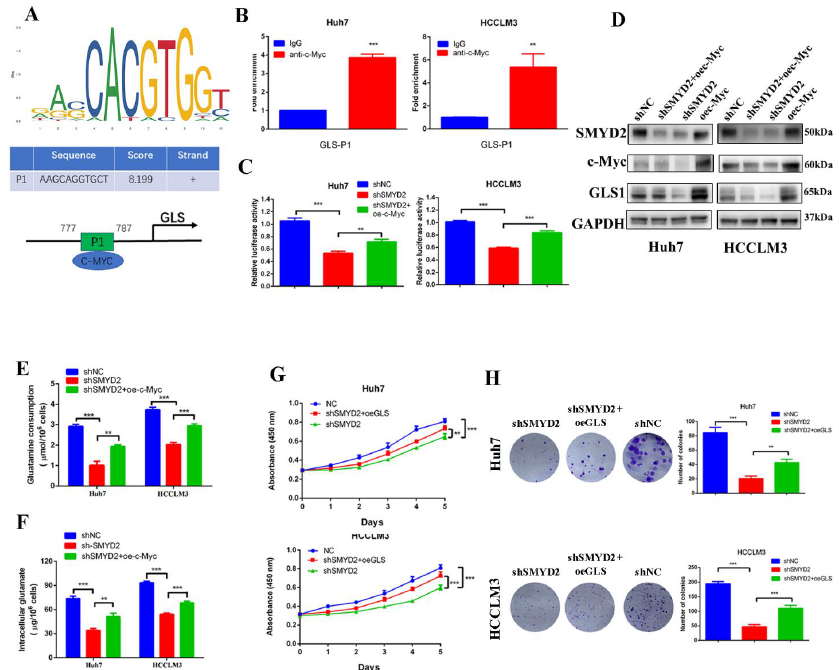
Figure 6. SMYD2 upregulates the expression of GLS1 through c-Myc. ( A ) Schematic illustration shows the potential c-Myc-binding site. ( B ) The enrichment of c-Myc on the GLS1 promoter was examined using ChIP- qPCR assay. The presented data were analyzed by Student’s t -test. ** p < 0.01, *** p < 0.001. ( C ) Luciferase reported assay to determine the GLS1 promoter activity in indicated HCC cells. Student’s t -test was used to analyze the data. Data are represented as mean ± SD. ** p < 0.01, *** p < 0.001.( D ) Western blotting was conducted to examine the protein level of c-Myc, GLS1, and SMYD2. ( E , F ) The glutamine consumption and intracellular glutamate level were detected in indicated HCC cells. ** p < 0.01, *** p < 0.001. Data are represented as mean ± SD. Data are from three independent experiments. Student’s t -test was used to analyze the data. ( G ) Cell viability was ex- amined by CCK-8 assay. ** p < 0.01, *** p < 0 .001. Student’s t -test was conducted to analyze the data. ( H ) Colony formation of the indicated HCC cells. ** p < 0.01, *** p < 0.001. Data are represented as mean ± SD. Student’s t -test was used to analyze the data.